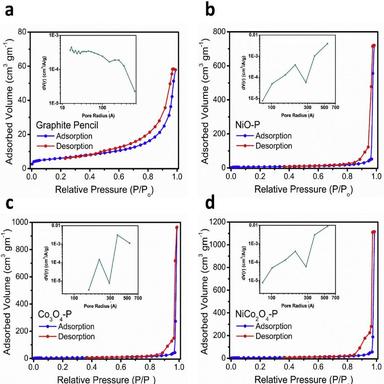
BET analysis of a. bare graphite pencil, b. NiOeP, c. Co3O4eP, and d. NiCo2O4eP (inset shows the pore size distribution) (P stands for PGR).